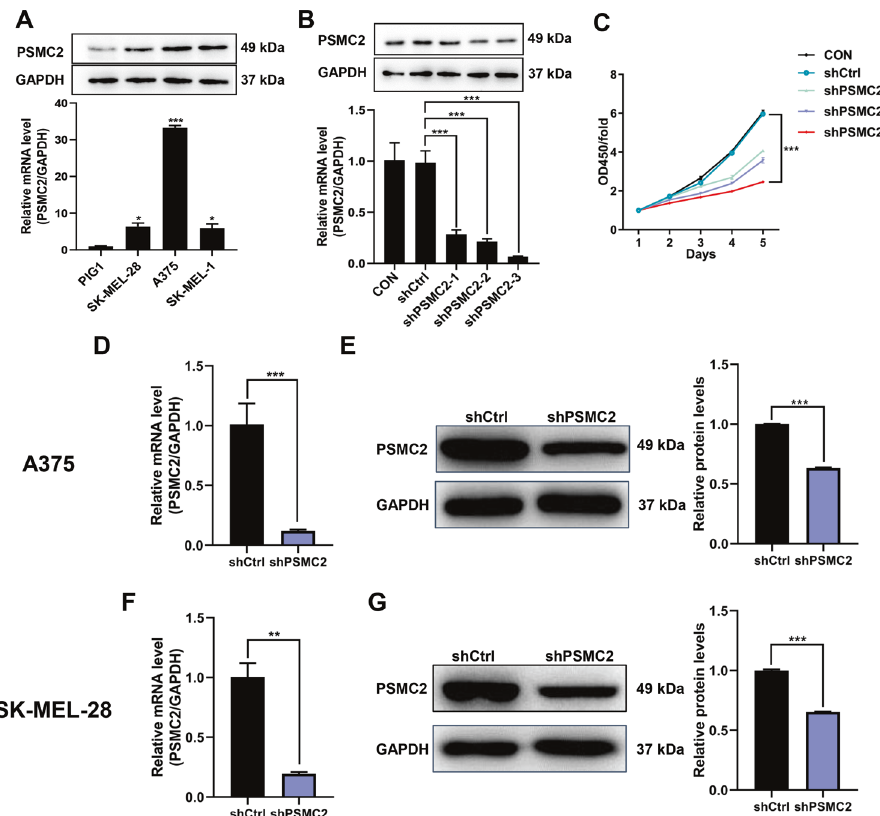
Fig. 2 PSMC2 shRNAs transfections. A The PSMC2 expression pro fi le at the protein level (upper part) and mRNA level (bottom part) in human melanoma cell lines (A375, SK-MEL-1, SK-MEL-28) and human epidermal melanocytes (PIG1). B Western blot (upper part) and RT-qPCR (bottom part) were used to assess the transfection ef fi ciency of PSMC2 shRNA-1 and shRNA-2 and shRNA-3 in A375 cells. C PSMC2 knockdown is associated with reduced proliferation in A375. CCK-8 assay was performed to measure the rate of cell proliferation of A375 after transfected with shPSMC2-1, shPSMC2-2, and shPSMC2-3 for 5 days. D , E RT-qPCR and Western blot were used to detect the expression of PSMC2 in A375 cells after shPSMC2 transfection. F , G RT-qPCR and Western blot were used to detect the expression of PSMC2 in SK-MEL-28 cells after shPSMC2 transfection. Each independent experiment was repeated at least three times. Data were expressed as the mean ± SD. * p < 0.05, ** p < 0.01 and *** p <